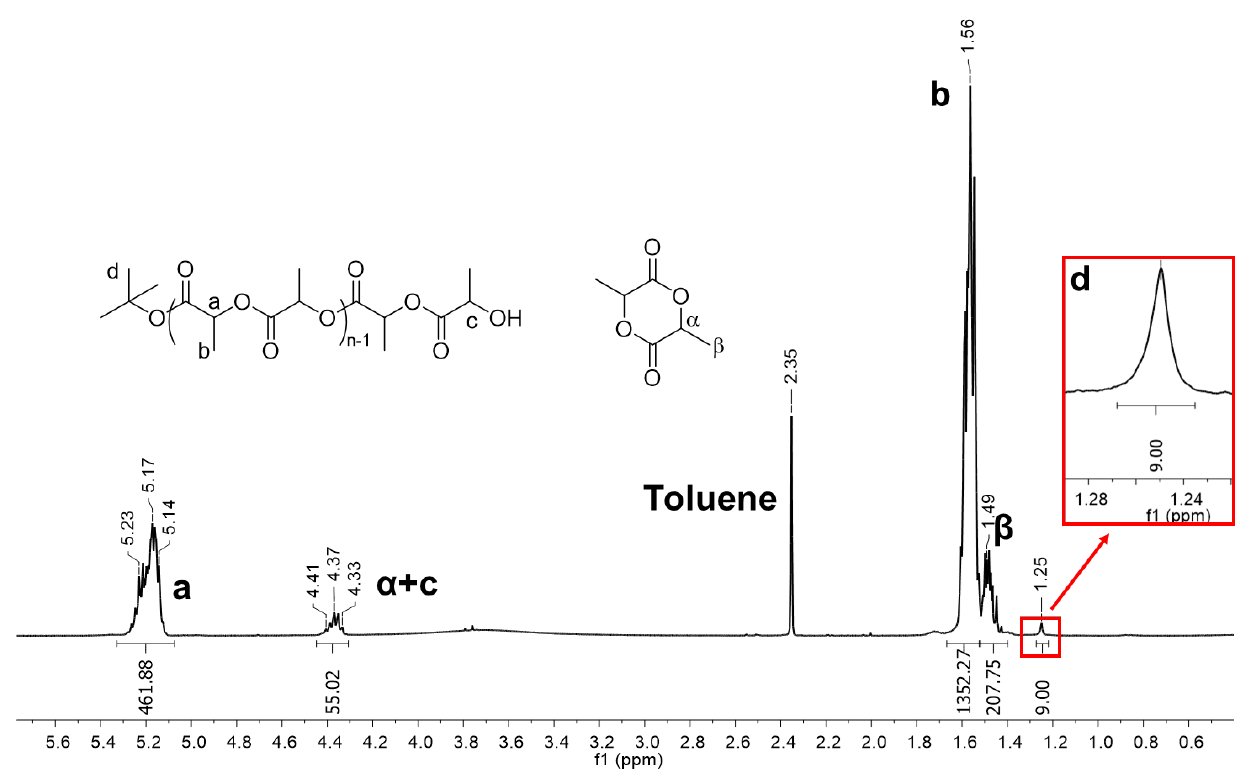
Figure 15. 1 H NMR (CDCl 3 , 400 MHz) spectrum of PLA prepared using 10 · 2MeCN (Table 3, entry 10).